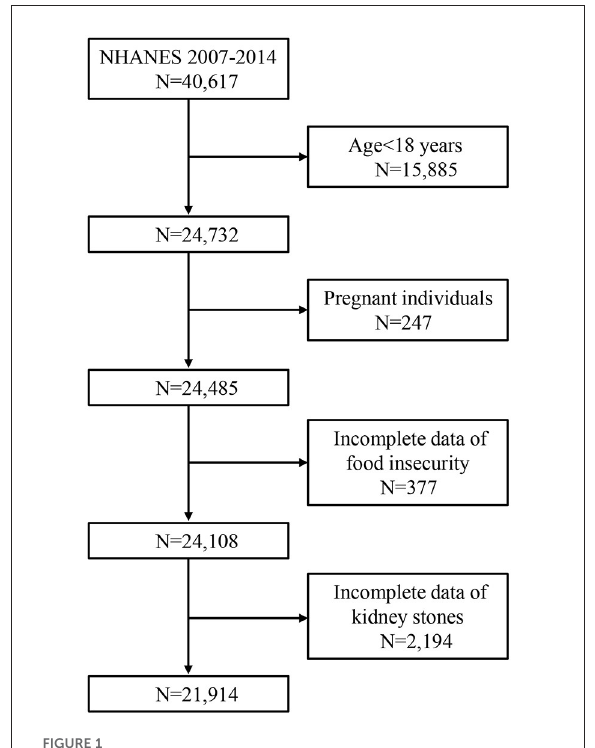
FIGURE1 Flowchart of the study population from NHANES